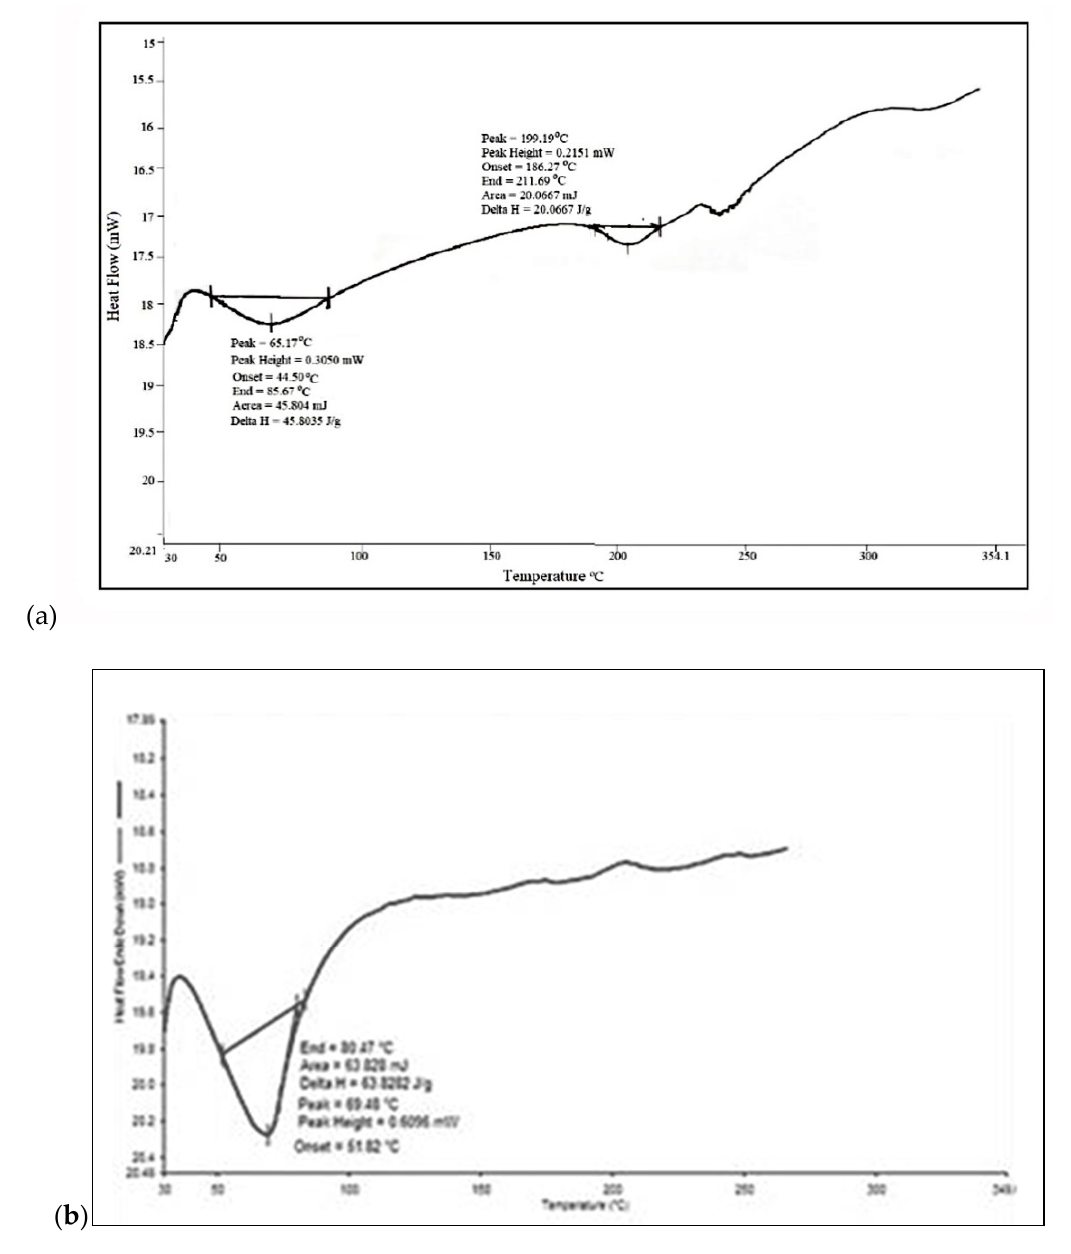
Figure 3. ADSC thermogram of the Plain mixture ( a ) and Thiolated reaction mixture ( b ).